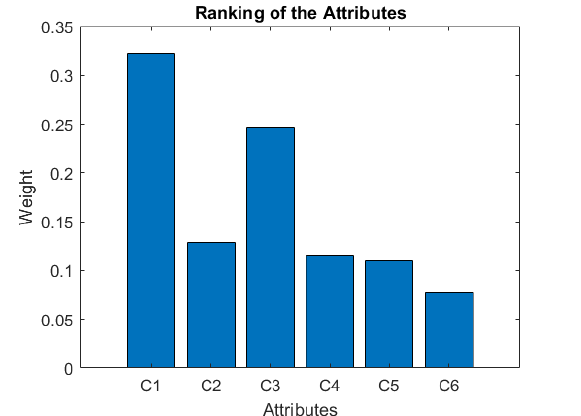
Figure 4. Ranking of the